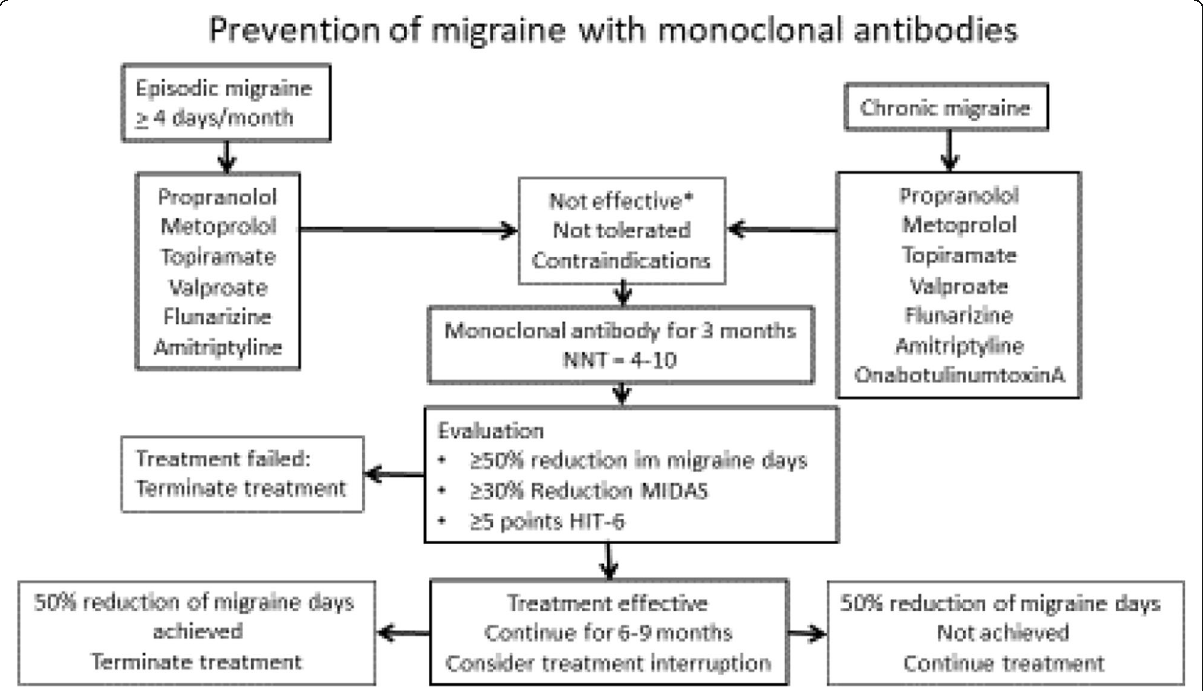
Fig. 3 Flow diagram for migraine prevention with monoclonal